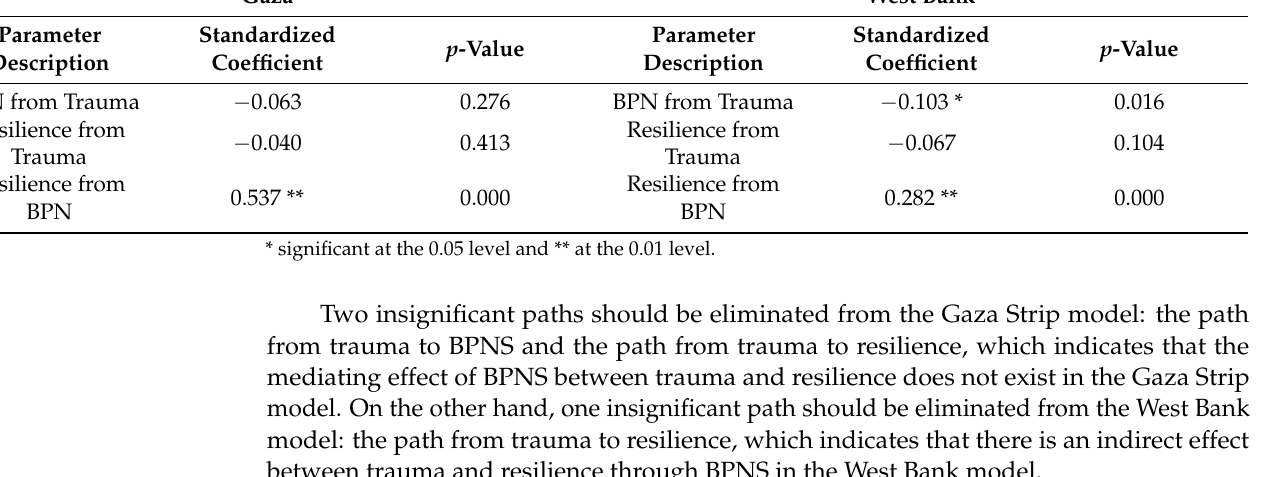
Figure 3. Structural Model BPNS mediates the effect of trauma on resilience. Table 2. Standardized regression weights for the mediation model (Vaillant). Gaza West